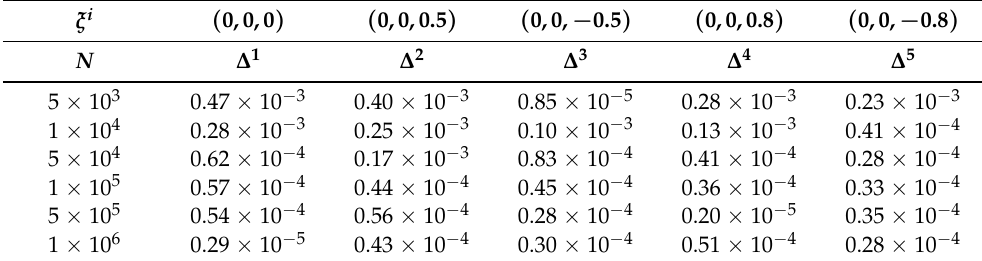
Figure 1. Results from Table 1, for Problem 3 (in Example 1).